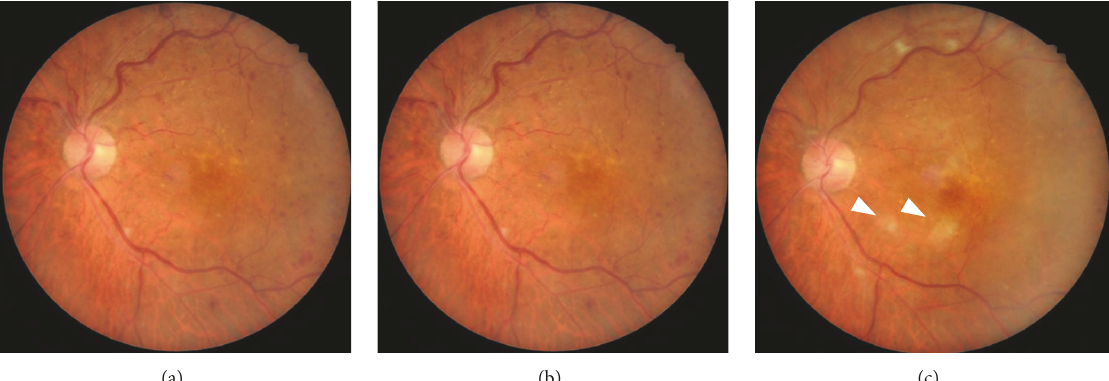
Figure 3: Fundus photograph images in the left eye (a) 1 month, (b) 2 months, and (c) 4 months after the initial visit. (c) Fundus photograph demonstrating cotton wool spots (arrowheads) located near the macula.